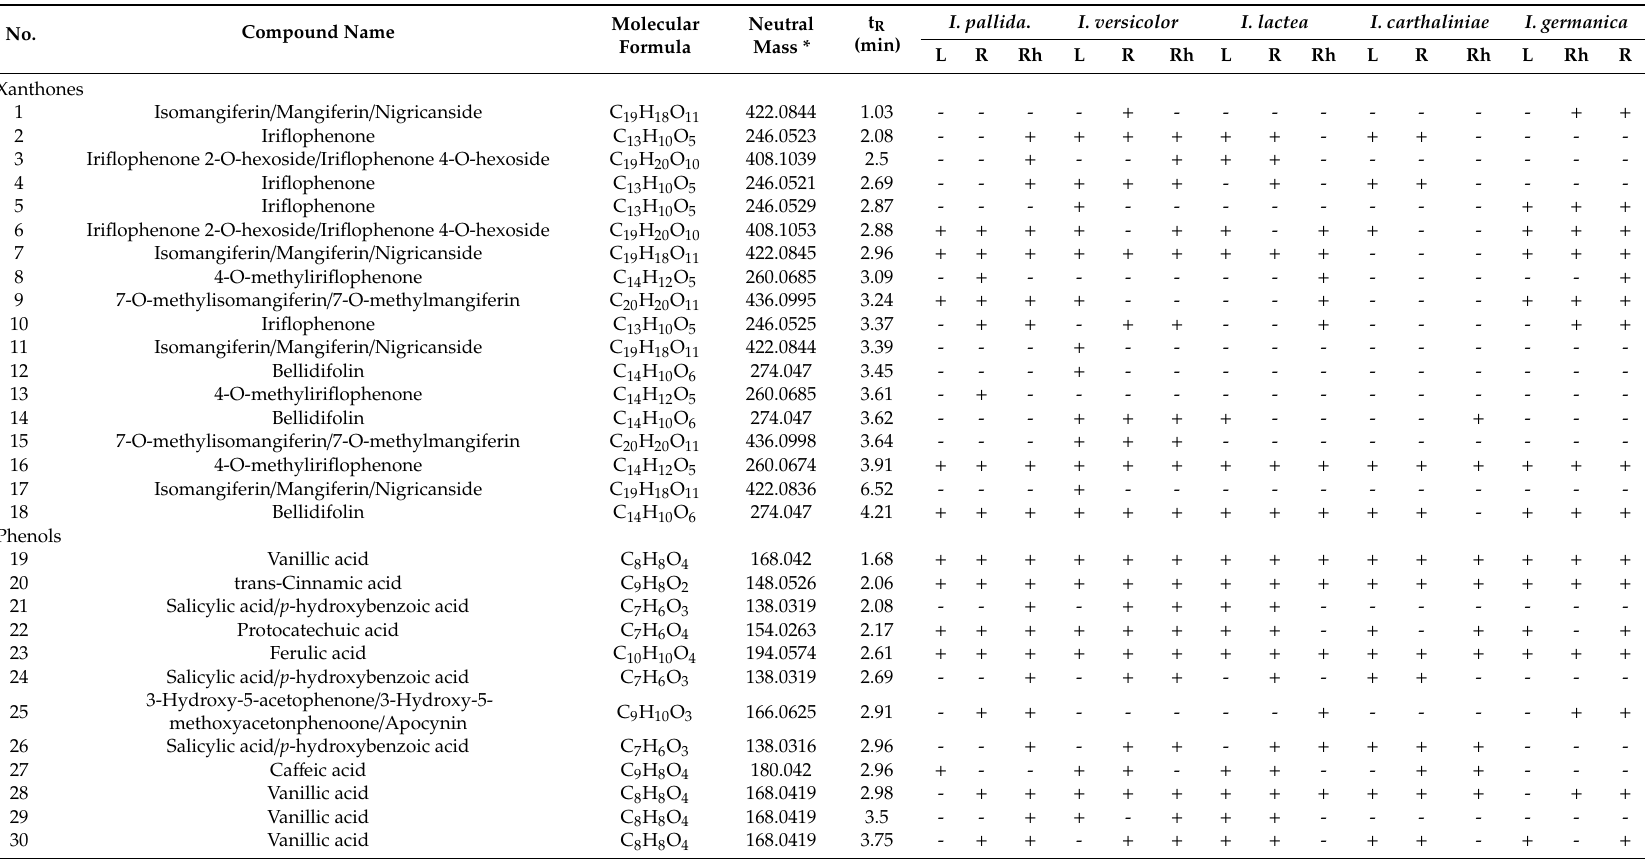
Table A1. Overview of phytochemicals detected and tentatively identified in Iris spp. by ultra-high performance liquid chromatography-high-resolution tandem mass spectroscopy (UHPLC–HRMS /